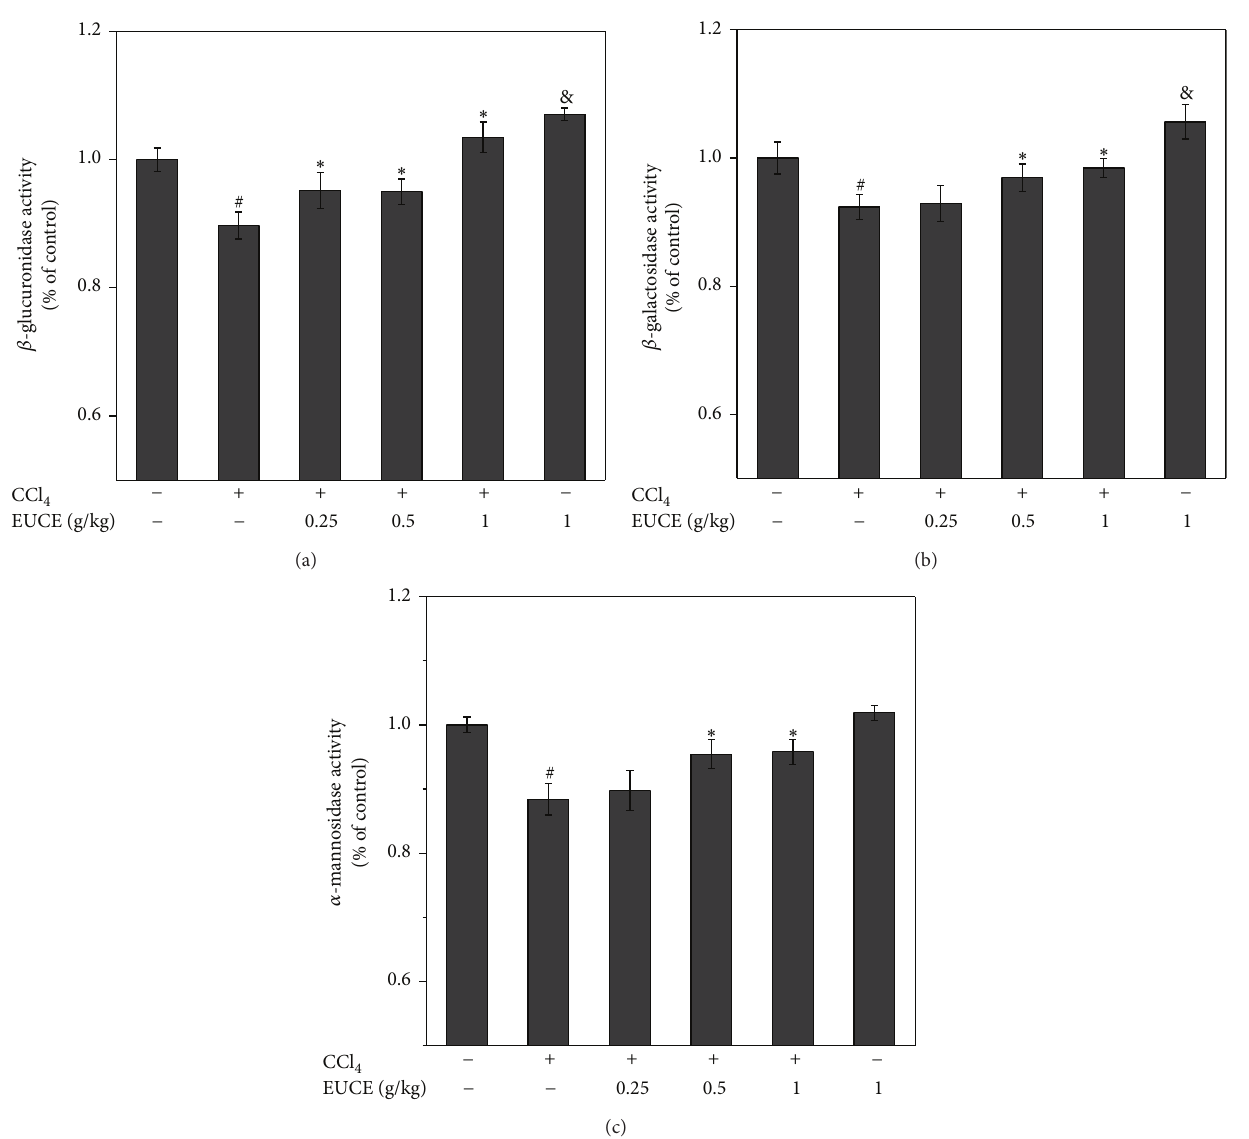
Figure 5: Effect of EUCE on CCl 4 -induced lysosomal enzymes activity. Rats were injected with 1mg/kg CCl 4 , and livers were isolated after 4 hours. The lysosomal enzymes activity was measured by a kit. Values are mean ± SD, 𝑛 = 8 . Asterisks indicate differences from the group treated with CCl 4 only ( ∗ 𝑃 < 0.05 ). & 𝑃 < 0.05 , # 𝑃 < 0.05 indicate a significant difference compared with the control